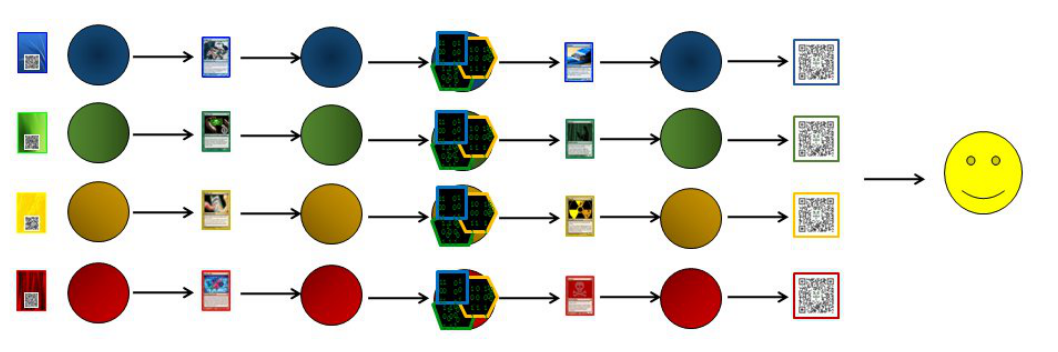
Figure 9. Modification of the breakout process to make it